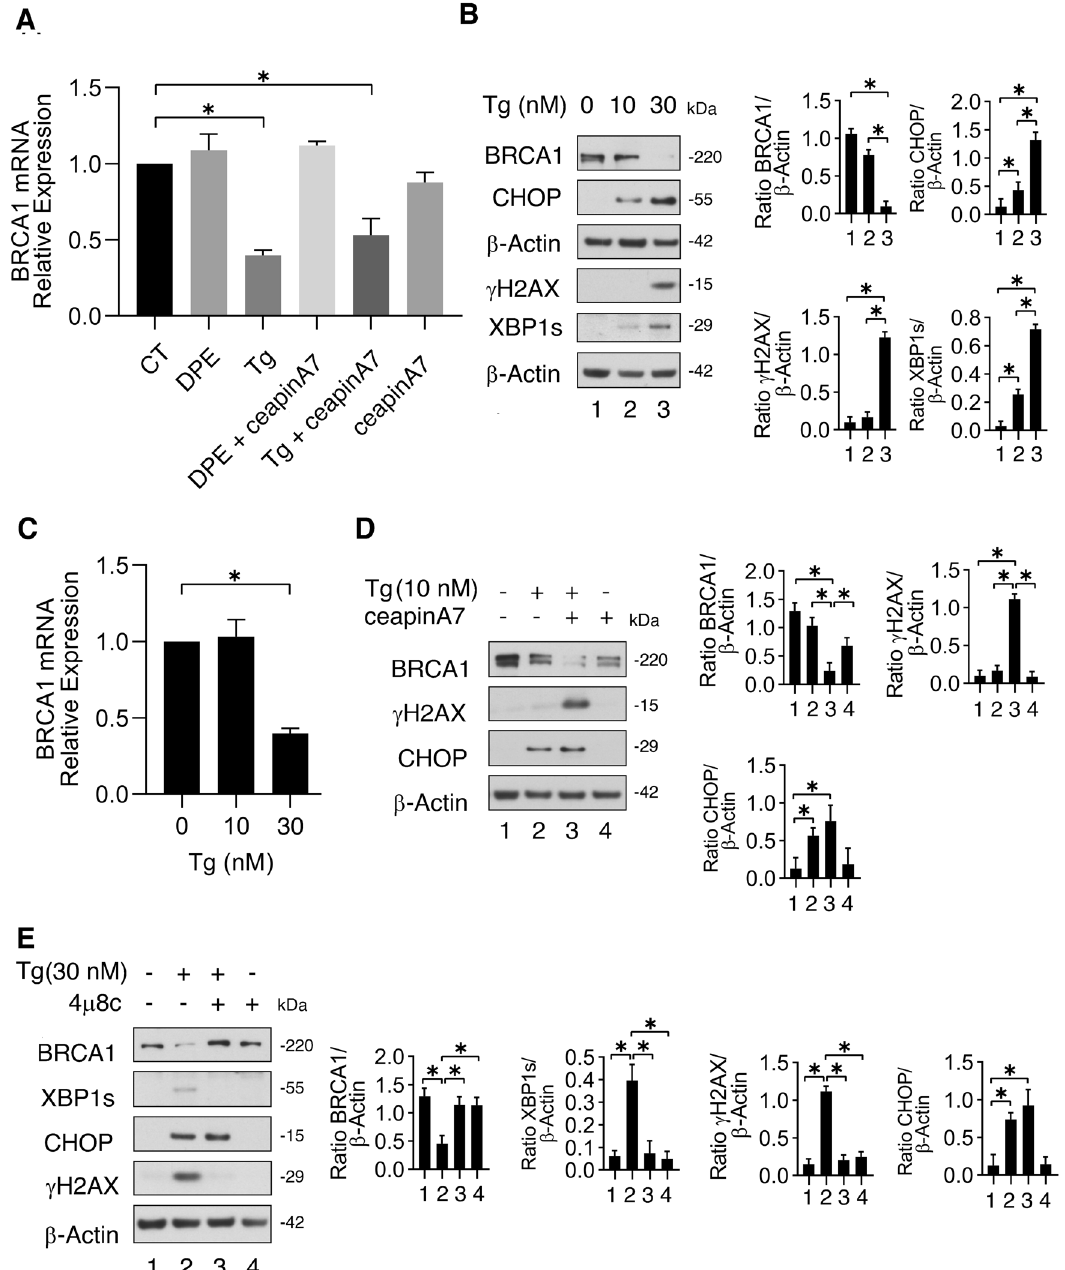
Fig. 3 ATF6 inhibitor downregulation of BRCA-1 occurs at post-transcriptional level, while Thapsigargin reduces BRCA-1 mRNA in a dose- dependent manner. A qRT-PCR of BRCA-1 in RKO cell line pre-treated or not with ceapinA7 (12 μ M) and treated or not with DPE (100 μ M) or Thapsigargin (Tg) (30 nM) or left untreated, as control for 48 h. Data are expressed relative to the geometric mean of the starting concentration of reference genes (GAPDH and B2M). The histograms represent the mRNA expression levels of BRCA-1 genes of three different experiments. Data are represented as the mean relative to the control plus S.D. * p value < 0.05. B RKO were treated with Thapsigargin (10 or 30 nM) or left untreated as control. After 48 h the expression of BRCA-1, CHOP, γ H2AX, XBP1s was evaluated by western blot analysis. β -Actin was used as loading control. The histograms represent the mean plus S.D. of the densitometric analysis of the ratio between the protein and β -Actin. * p < 0.05. C qRT-PCR of BRCA-1 in RKO treated with Thapsigargin (10 or 30 nM) or left untreated as control for 48 h. Data are expressed relative to the geometric mean of the starting concentration of reference genes (GAPDH and B2M). The histograms represent the mRNA expression levels of BRCA-1 genes of three different experiments. Data are represented as the mean relative to the control plus S.D. * p value < 0.05. D RKO cells were pre-treated or not with ceapinA7 (12 μ M) for 1 h and then treated or not with Thapsigargin (10 nM) or left untreated, as control. After 48 h of treatments, the expression of BRCA-1, γ H2AX, and CHOP was evaluated by Western blot analysis. β -Actin was used as loading control. The histograms represent the densitometric analysis of the ratio of speci fi c protein/ β -Actin of three different experiments. Data are represented as the mean plus S.D. * p value < 0.05. E RKO cells were pre-treated or not with 4u8c (10 μ M) for 1 h and then treated or not with Thapsigargin (30 nM) or left untreated, as control. After 48 h of treatments, the expression of BRCA-1, γ H2AX, CHOP, and XBP1s was evaluated by western blot analysis. β -Actin was used as loading control. The histograms represent the densitometric analysis of the ratio of speci fi c protein/ β -Actin of three different experiments. Data are represented as the mean plus S.D. * p value < 0.05.